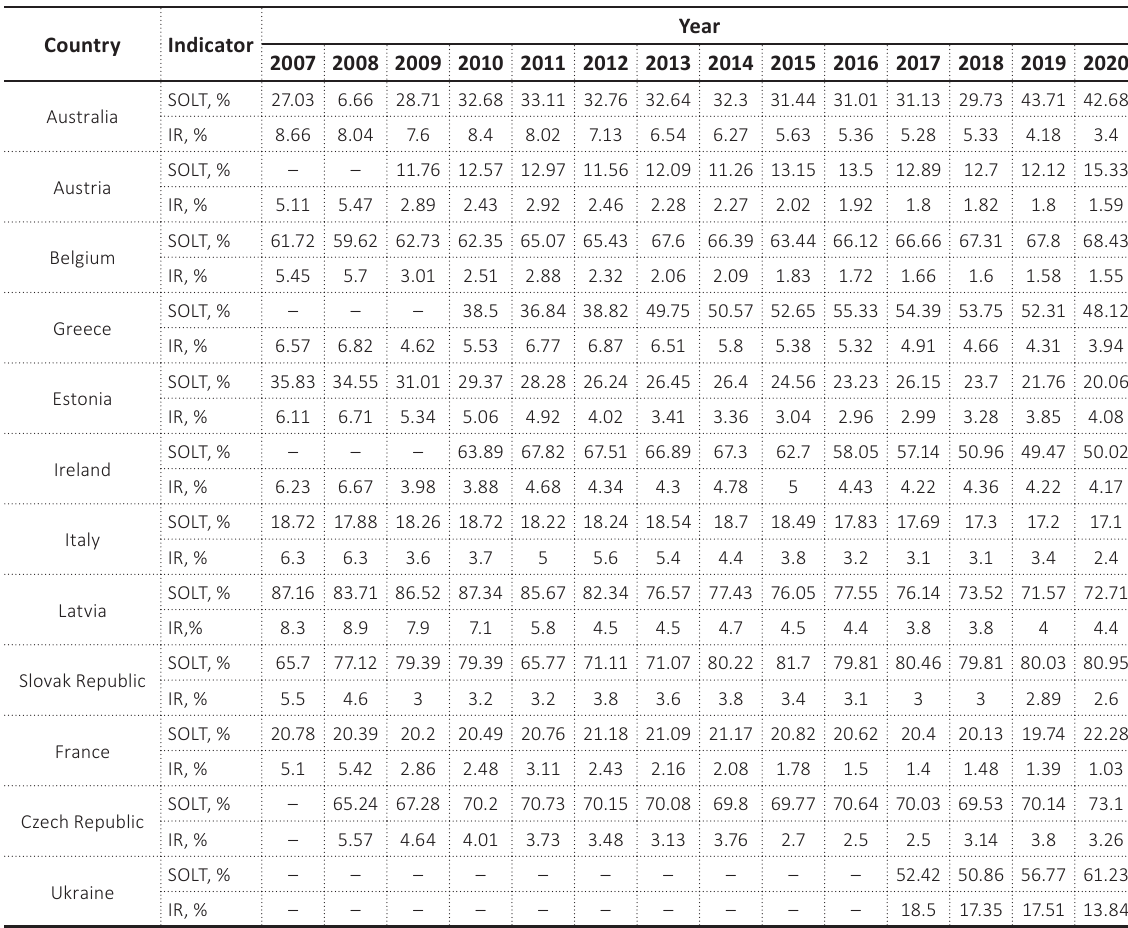
Source: OECD (2020).